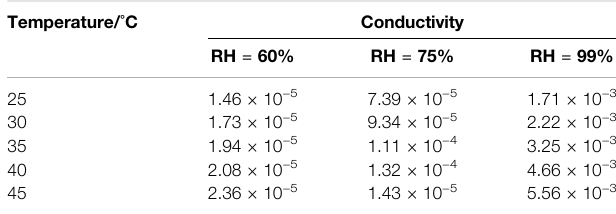
TABLE 1 | Proton conductivity data of 1 (S cm − 1 ).